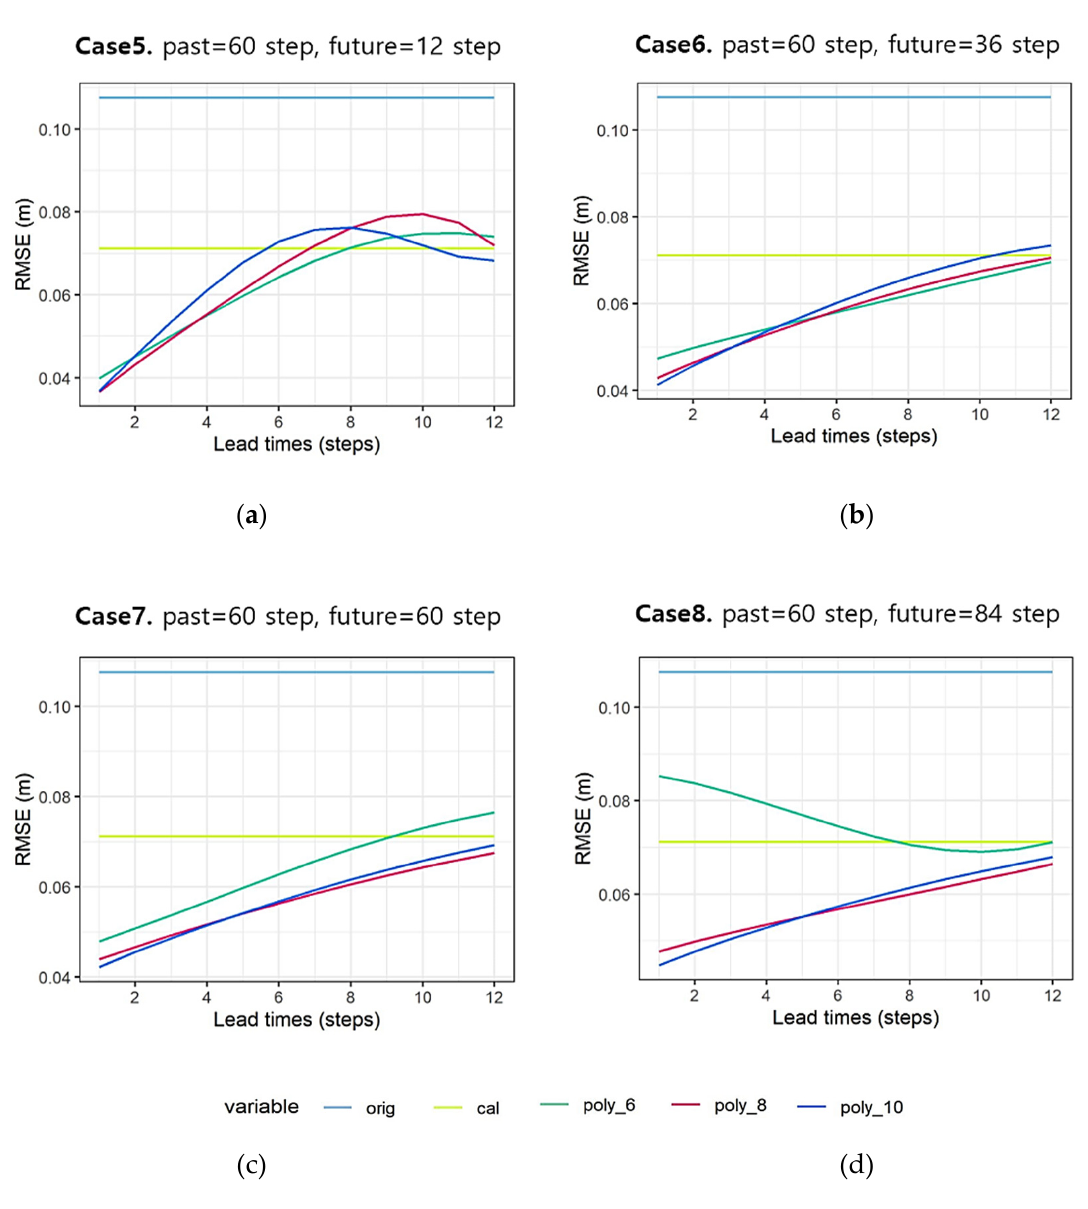
Figure 8 . Tidal prediction performance by varying polynomial orders according to various future Figure 8. Tidal prediction performance is based on varying polynomial orders according to various DA window periods: (a) 12 future steps, (b) 36 future steps, (c) 60 future steps, and (d) 84 future future DA window periods: ( a ) 12 future steps, ( b ) 36 future steps, ( c ) 60 future steps, and ( d ) 84 steps with the same 60 past steps for all cases. future steps, with the same 60 past steps in all